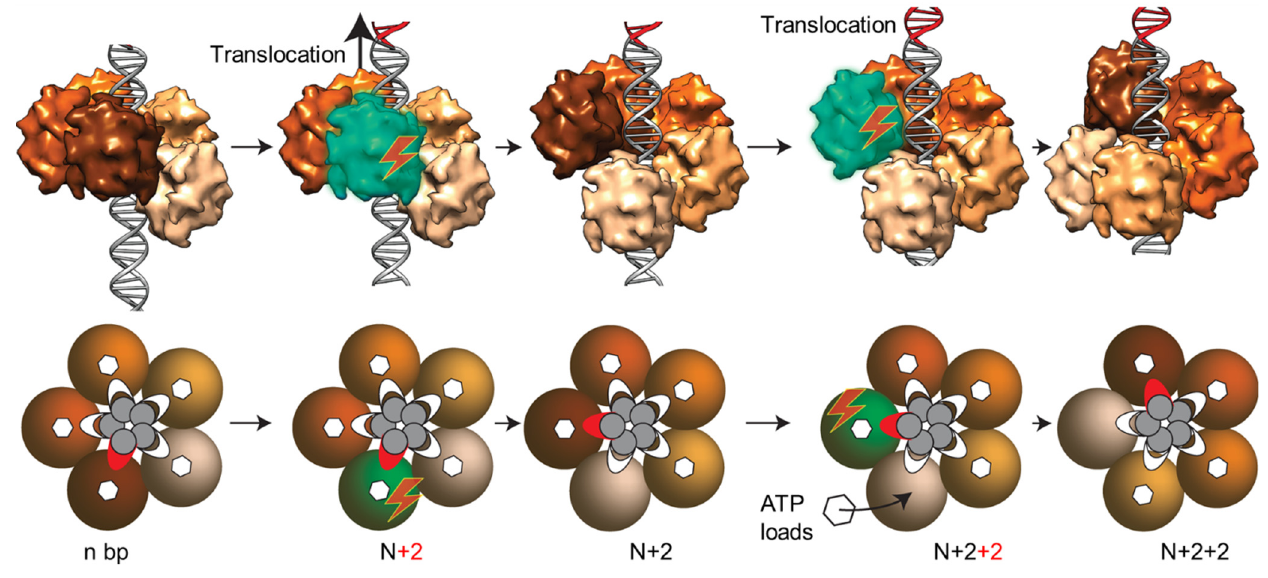
Figure 7. A model for the continuous burst packaging mechanism by the phage T4 DNA-packaging motor. The pentameric motor is shown to interact with DNA helix at different strengths, as depicted by increasing color intensity with increasing strength of the DNA grip. The top row shows surface views, and the bottom row shows spheres of the proposed DNA-binding domains of gp17. The firing subunit is shown in green, DNA helix in gray, ATP as hexagons, DNA grips as white patches, and the one with the strongest DNA grip as a red patch. “n” represents the motor prior to translocation, and “N+2” and “N+2+2” represent the motor when a subunit fires, causing 2 bp translocation. See the text for the details on the mechanism.